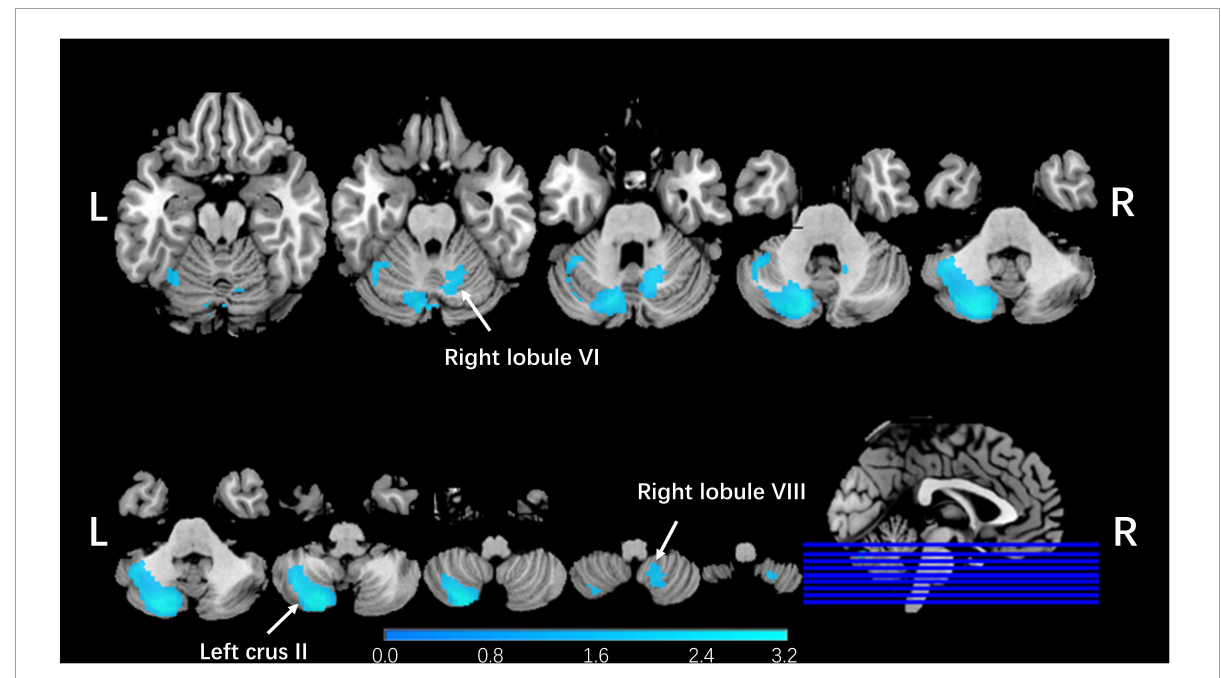
FIGURE2 Regional cerebellar GMV changes in patients with schizophrenia compared with healthy controls in our meta-analysis. The blue color represented lower gray matter volume in left Crus II, right lobule VI, and right lobule VIII compared with healthy controls in our meta-analysis. The corresponding cerebellar regions were pointed out at the peak coordinate